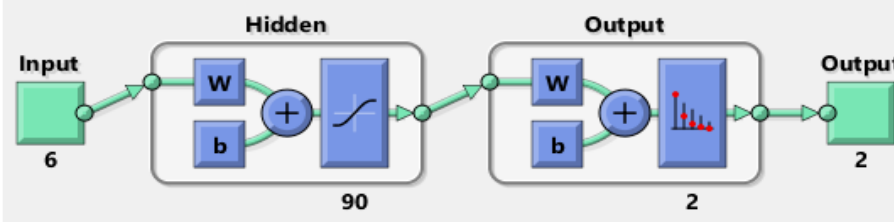
Figure 1. Network structure for <leak> and <complication (y/ n )>.